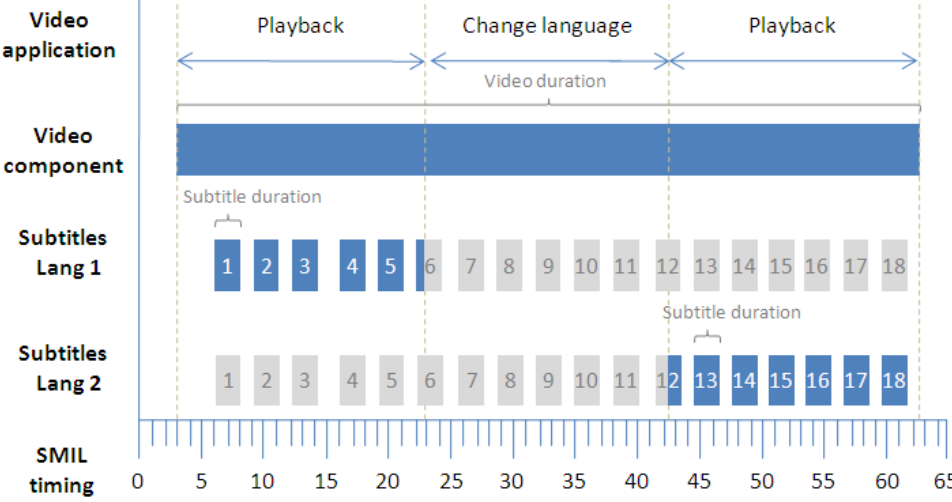
Figure 6. Strip diagram of basic timing support with a subtitle language change